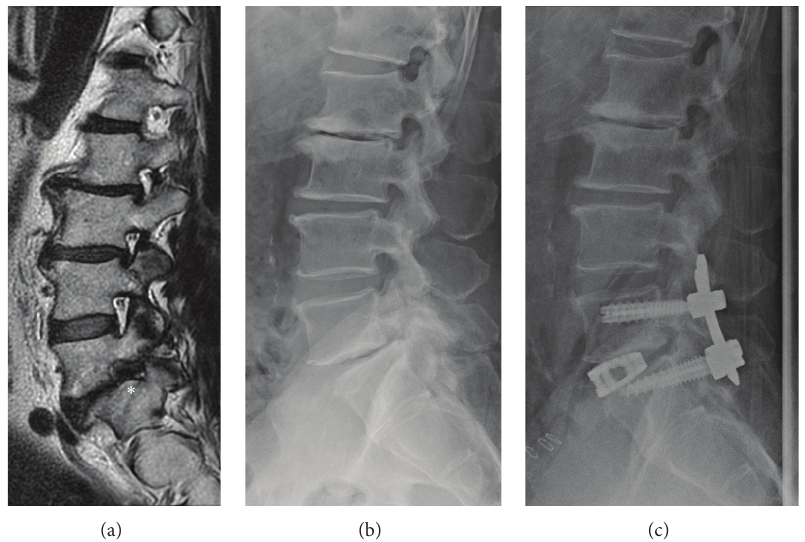
Figure 4: (a) Sagittal T2-weighted MRI showing foraminal stenosis at L5-S1 ( ∗ ). (b) X-ray image showing L5-S1 disk narrowing and L5 spondylolytic spondylolisthesis before surgery. (c) X-ray image after